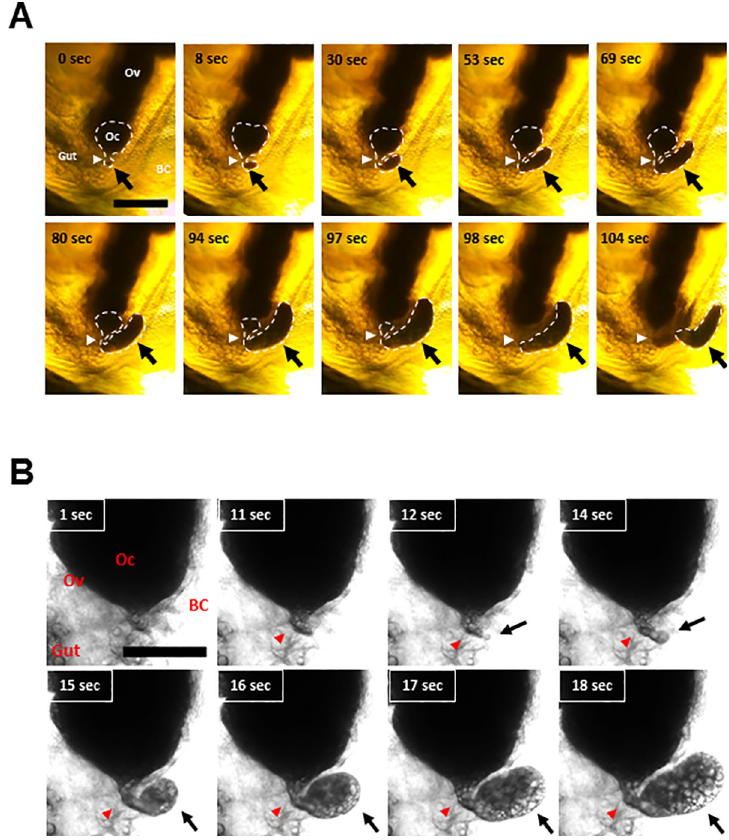
Fig 1. Live images of parthenogenetic eggs undergoing oviposition in Daphnia magna . The oviposition of parthenogenetic eggs was observed with a stereo- (A) and a light microscope (B). The dashed line indicates the outline of an ovulating egg. Arrowheads and arrows indicate the egg canal and extruded eggs, respectively. The time lapse after the initial observation is indicated in each panel. Scale bar, 200 μ m. BC, Brood Chamber; Oc, Oocyte; Ov, Ovary. The movie files are deposited as S1 and S2 Movie